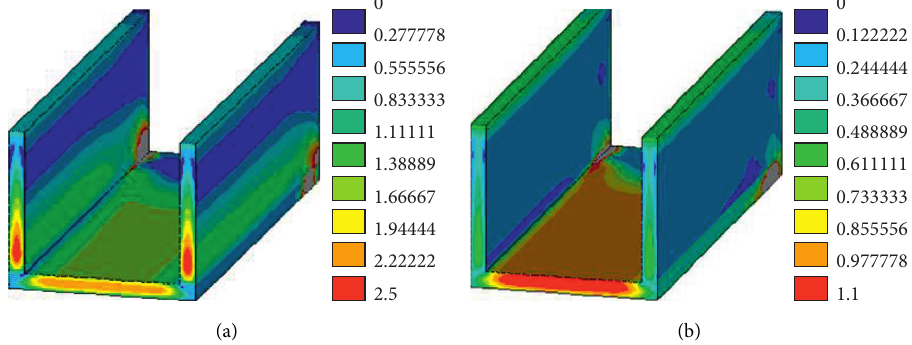
Figure 4: Stress envelope diagram of center section of BC and IC (MPa).